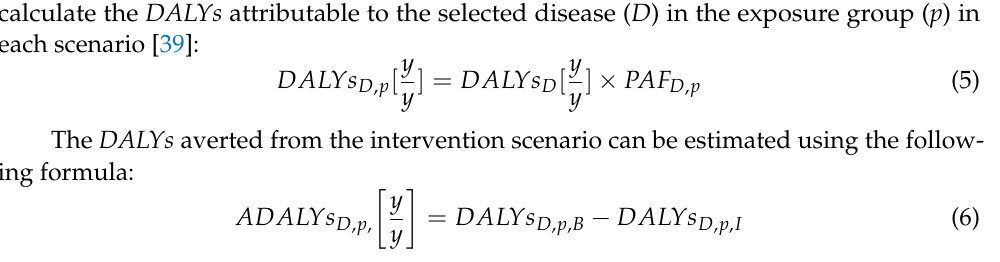
Table 2. Total DALYs of the most critical diseases in UB, Mongolia [37].